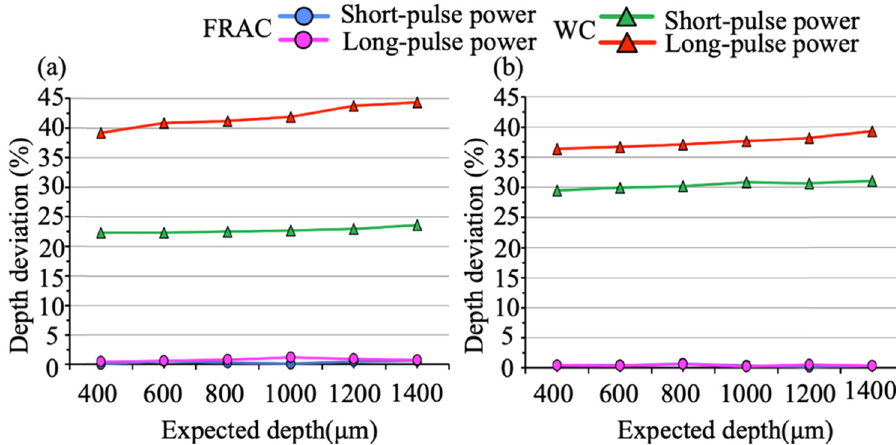
Figure 12: The depth deviation under di ff erent pulse of blind holes: ( a ) tungsten steel electrode; ( b ) brass electrode ( Short - pulse power: frequency = 120 kHz, pulse width = 3 µs, current = 2.5, voltage = 90 V, gain coe ffi cient = 15; long - pulse power: frequency = 130 kHz, pulse